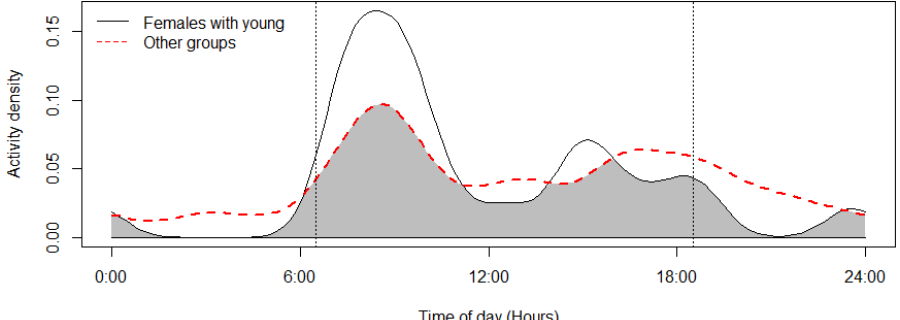
Figure 3. Activity overlap at the monitored water troughs of mouflon groups with females and young and other mouflon groups (coefficient of overlap Δ = 0.72). Sunrise and sunset are marked at their average time for the study period (gray zone shows the overlap area).